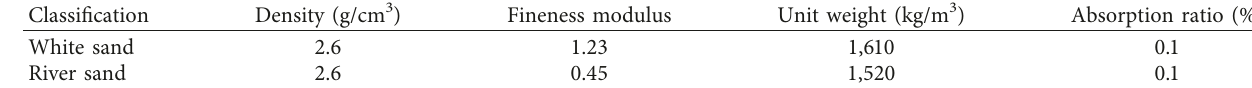
Table 6: Physical properties of aggregates.